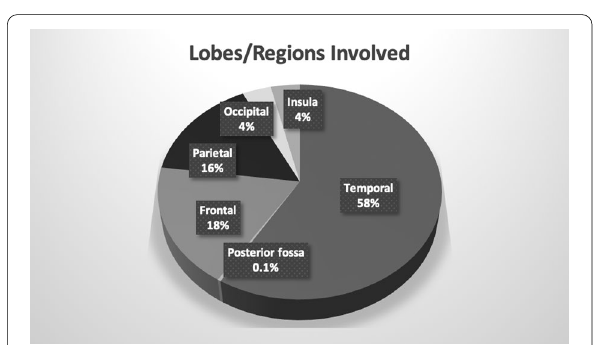
Fig. 2 Pie chart of brain lobes/regions involved by the imaging